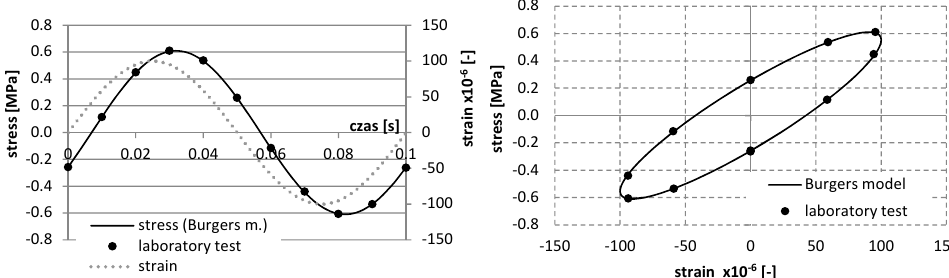
Figure 10. The results of laboratory study and the approximation of curves σ – ε using the Burgers model in the dynamic test at the temperature 25 °C (asphalt mixtures with an asphalt content of 4.5%).